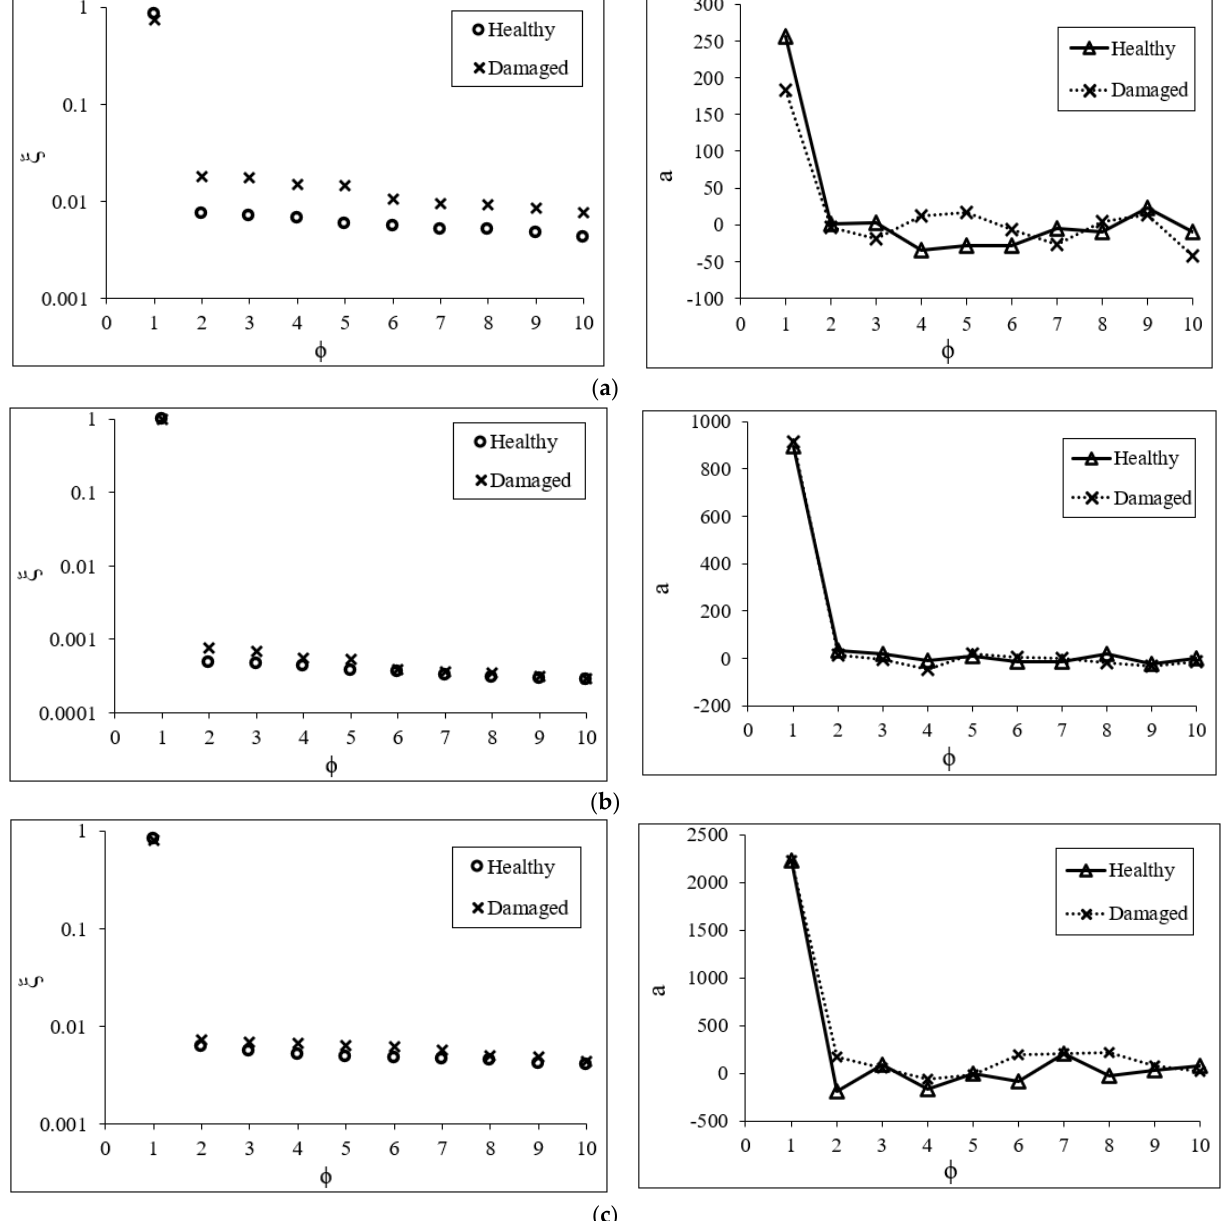
Figure 12. Spatial distribution of ξ and a for ϕ 1 … ϕ 10 in the wake of healthy and damaged VAWT, based on ( a ) pressure, ( b ) velocity, and ( c ) vorticity data.